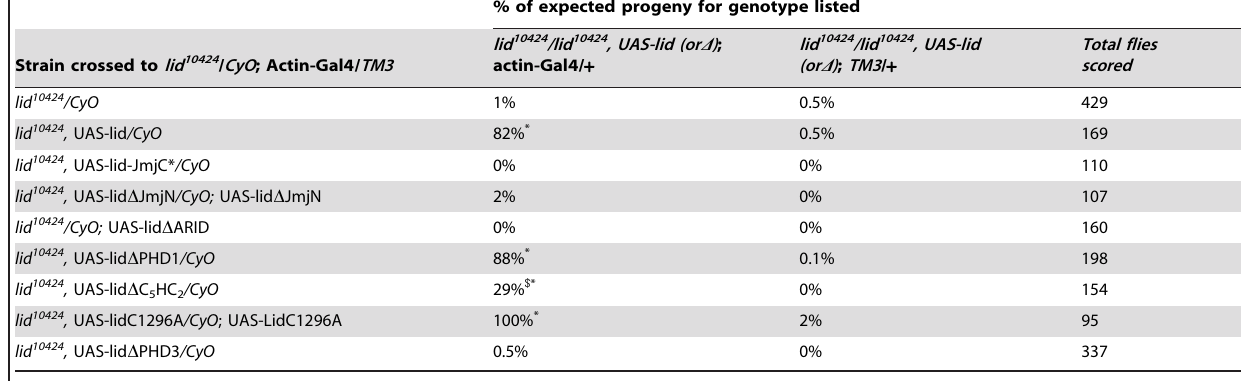
% of expected progeny for genotype listed